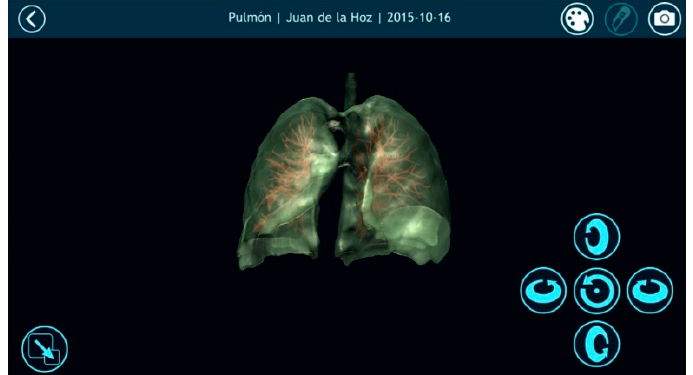
Figure 16. Visualization of a segmented lung with its veins and arteries in the personal computer (PC) version of the visualization platform, with transparency applied to the lung mesh.